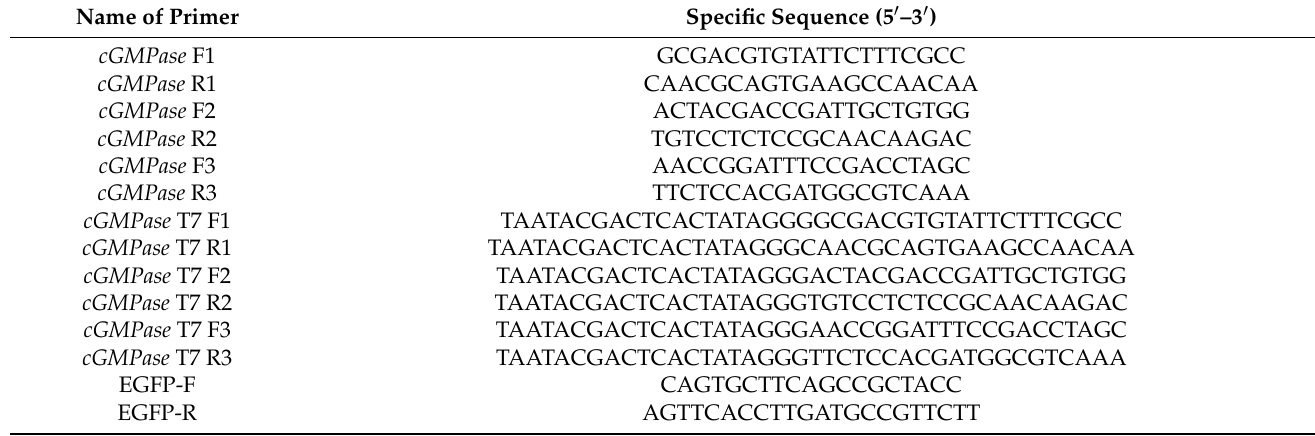
Table 2. Primers used in the experiment process. Specific Sequence (5 (cid:48) –3 (cid:48)